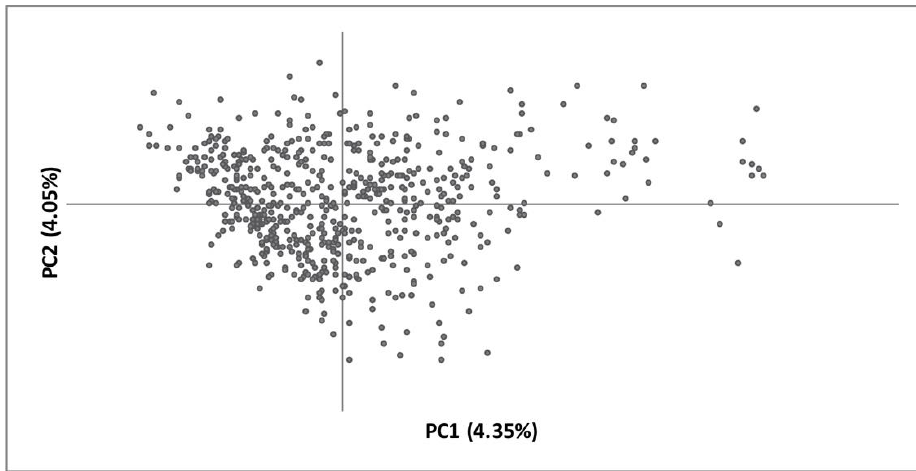
Figure 3. Genetic diversity over time, based on 646-bp of sequence from the mitochondrial control region. Haplotype diversity ( H d , top panel), observed heterozygosity ( H O , middle panel), and the average number of nucleotide differences ( k , lower panel) all show a similar pattern of decreasing variation over time, punctuated by an increase in 2000–2001.